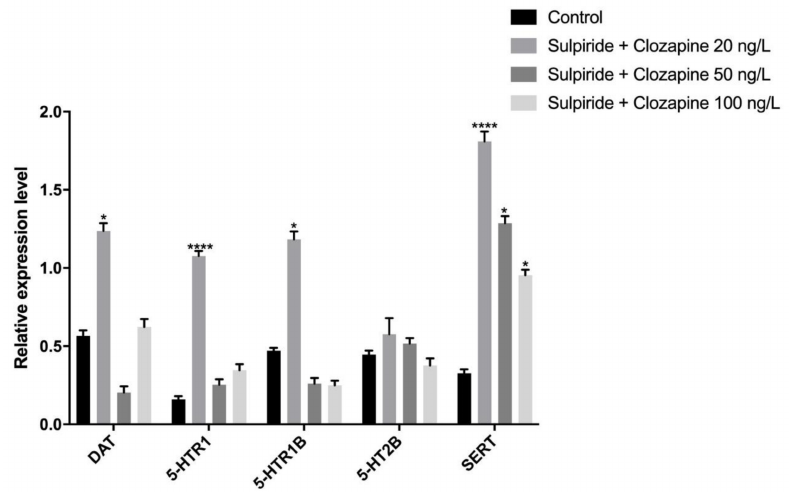
Figure 7. Sulpiride and clozapine mixed exposure for 14 days induced changes in protein expression levels of functional molecules of DA and 5-HT neurotransmitter systems in octopus brain tissue. Note: * compared with the control group, p < 0.05; **** compared with the control group, p < 0.0001; n =